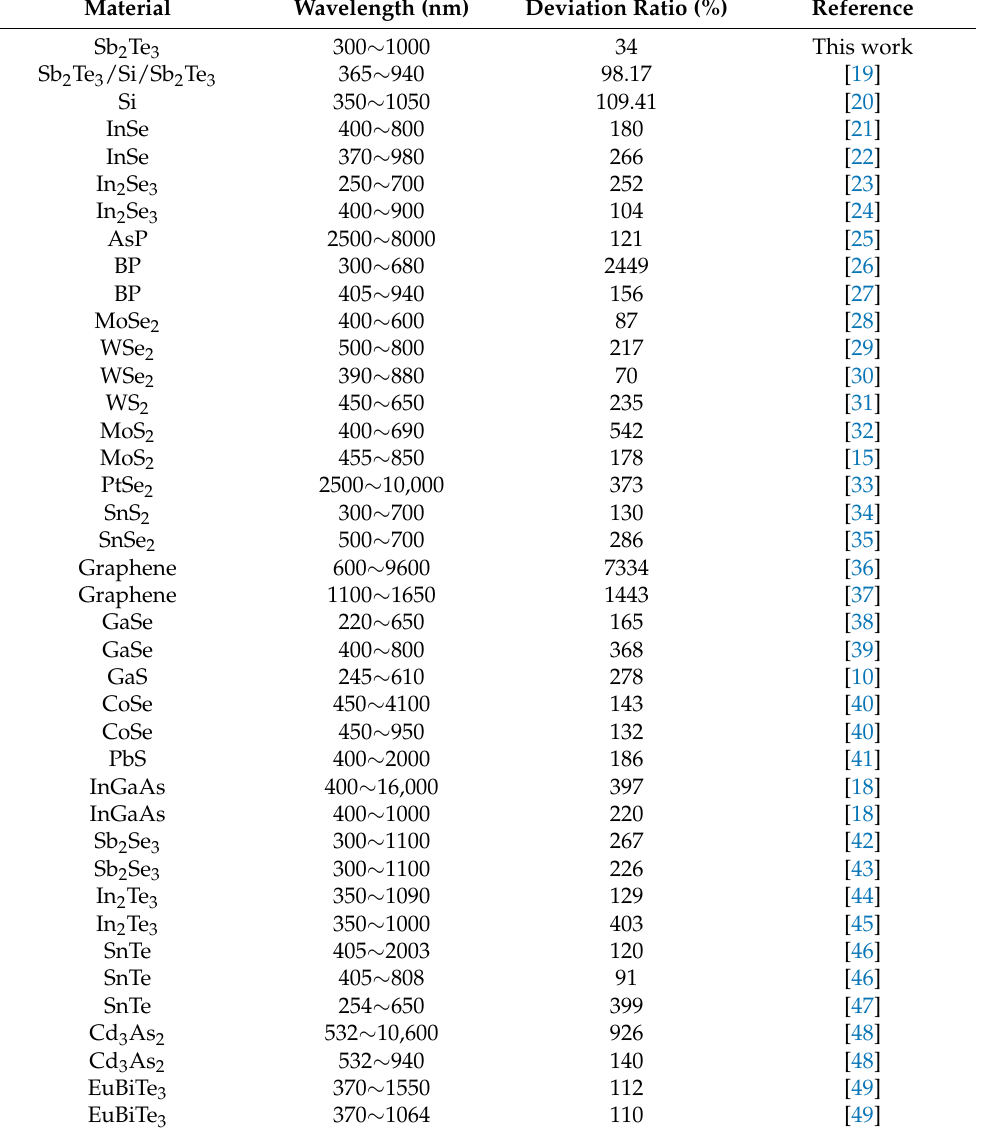
Table 2. List of the wavelength range and the deviation ratio of photocurrent for reported broadband light